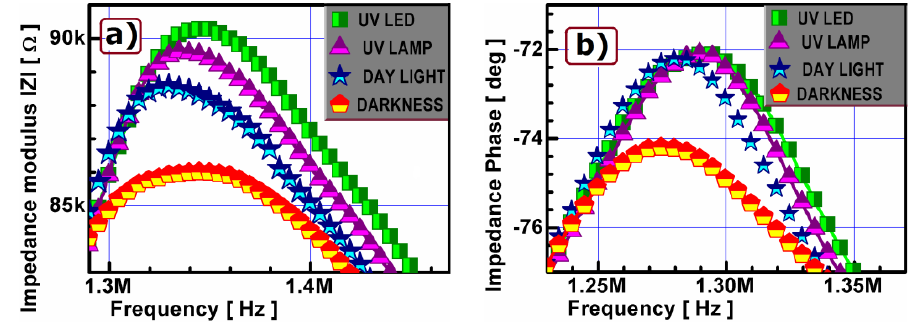
Figure 4. Light conditions influence on PLZT fiber impedance modulus |Z| ( a ) and phase P ( b ) at the antiresonance peak of frequency